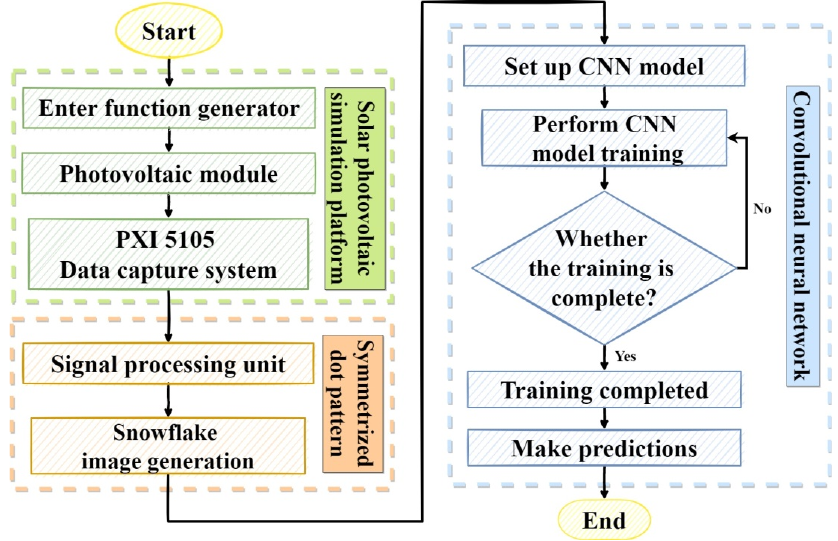
Figure 9. Fault recognition analysis process.